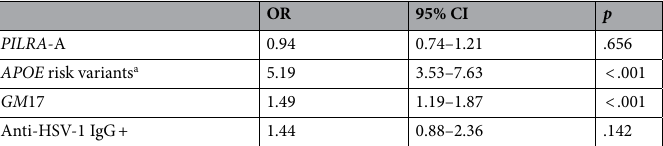
Table 2. Conditional logistic regression of Alzheimer’s disease risk with the PILRA R78G-A allele, APOE risk variants, the GM 17 allele and anti-HSV-1 IgG. OR Odds ratio, CI Confidence interval, APOE Apolipoprotein E. a Genotype ε3/ε4 or